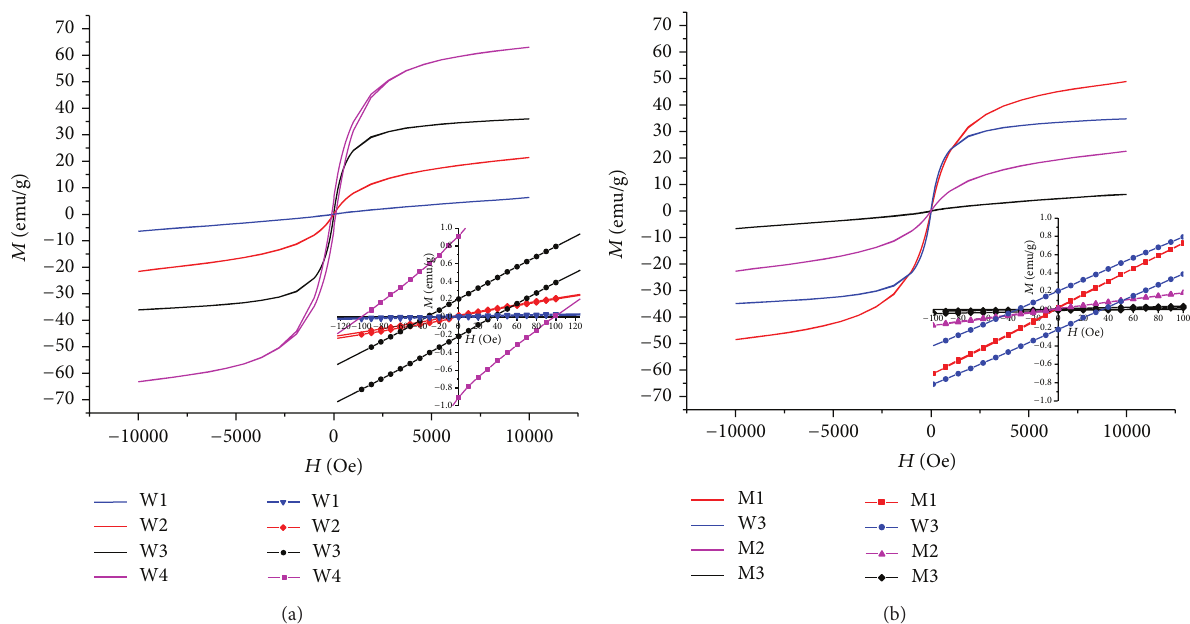
Figure5:Magnetizationcurvesforas-synthesizednanoparticlesshowingtheeffectof(a)watertosurfactantmolarratio(R)(b)concentration of metal